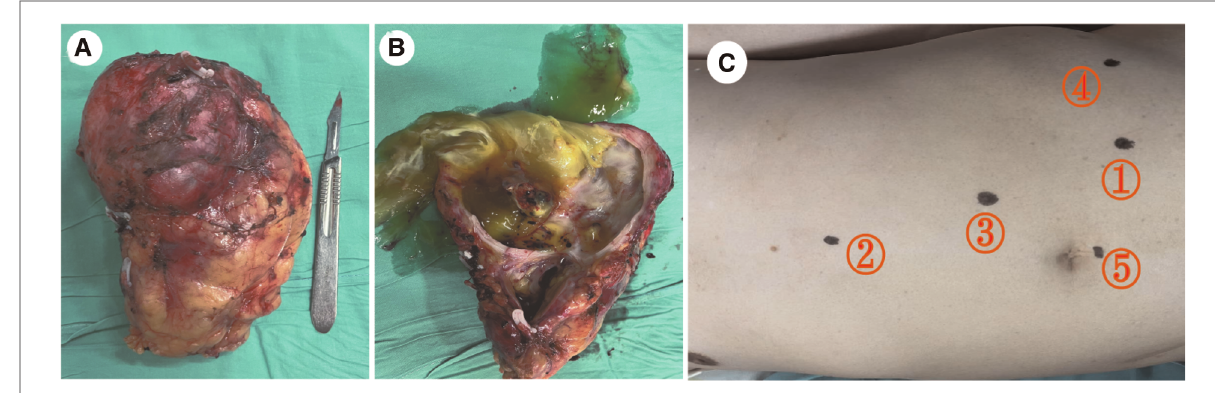
FIGURE 3 Fresh specimen of the left kidney with mass after radical resection. (A) Gross specimen: The tumor was associated with the kidney and located at the inferior pole. (B) Resection along the vertical axis: The tumor has a large amount of mucus with a focal grayish yellow appearance and thin wall. (C) The ports